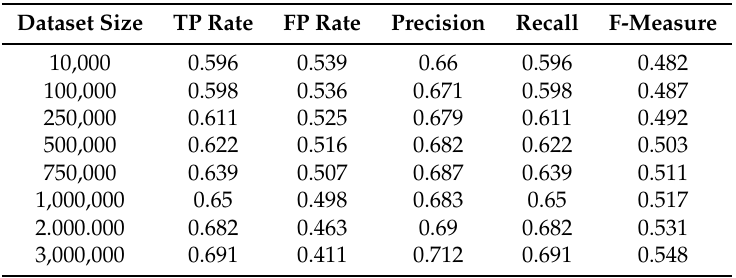
Table 6. Classification of Multilayer Perceptron for different dataset sizes.